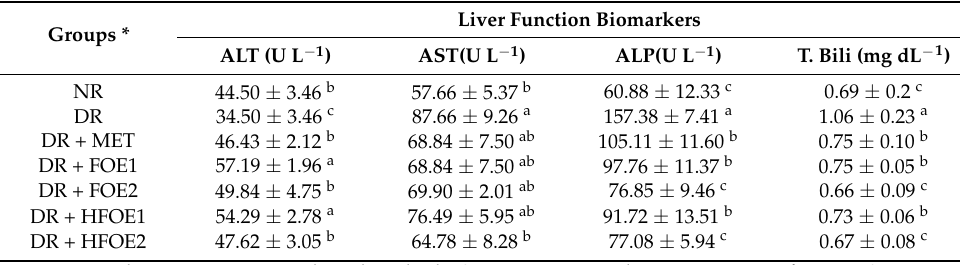
Table 6. Effect of orally administrated FOE and HFOE on liver function biomarkers in STZ-induced diabetes in rats (mean ± SE), n =